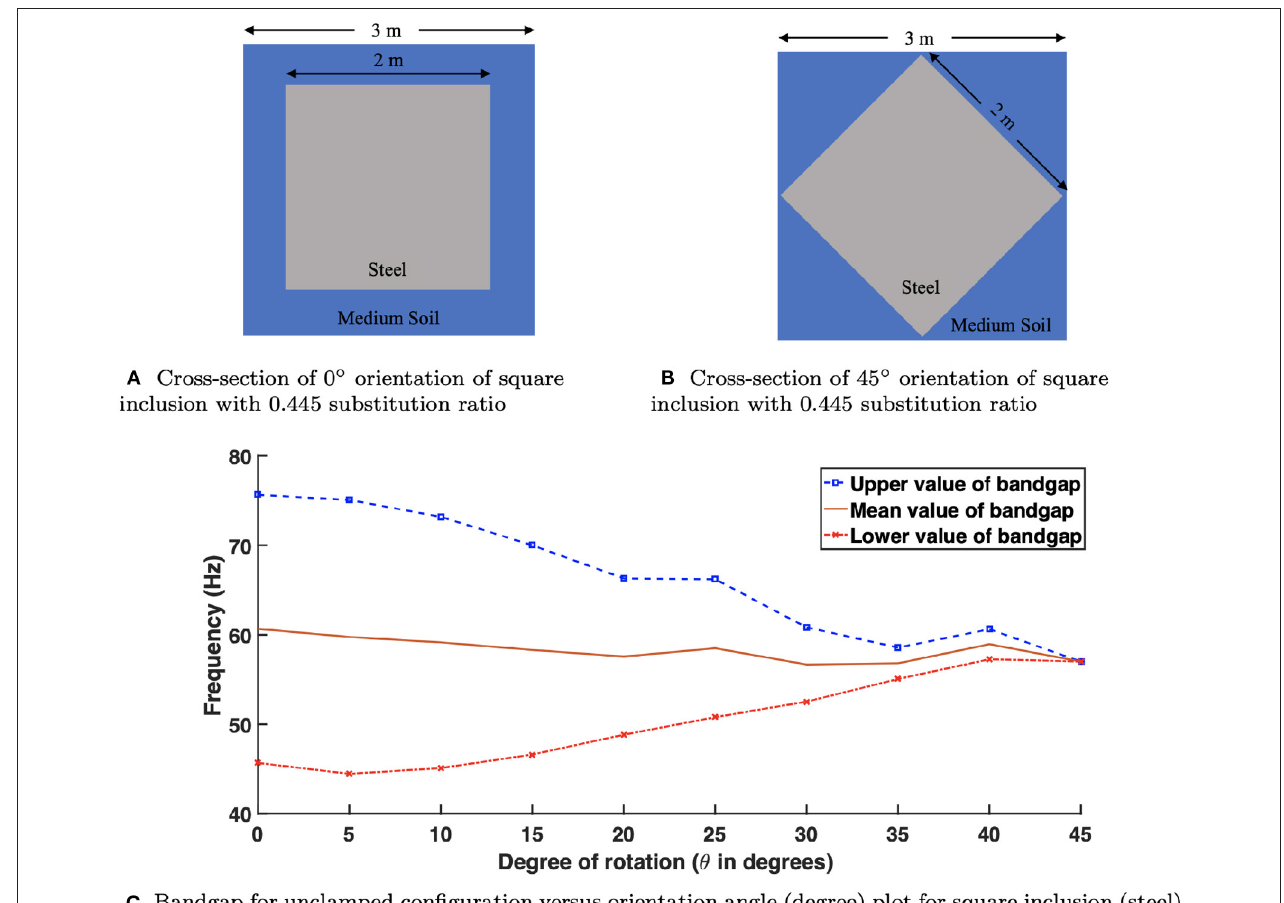
FIGURE 6 | Effect of change in orientation angle (in degrees) of unclamped regular-shaped square steel inclusion (2 × 2 × 10 m) with 0.445 substitution ratio in medium soil (3 × 3 × 10 m; E = 153 MPa, µ = 0.33, and ρ = 1,800 kg / m 3 ) on bandgap; (A,B) show the cross-section of 0 and 45 ◦ angle orientation of unclamped square inclusion; and (C) shows the declining trend in bandgap with increase in angle from 0 to 45 ◦ in anticlockwise direction.